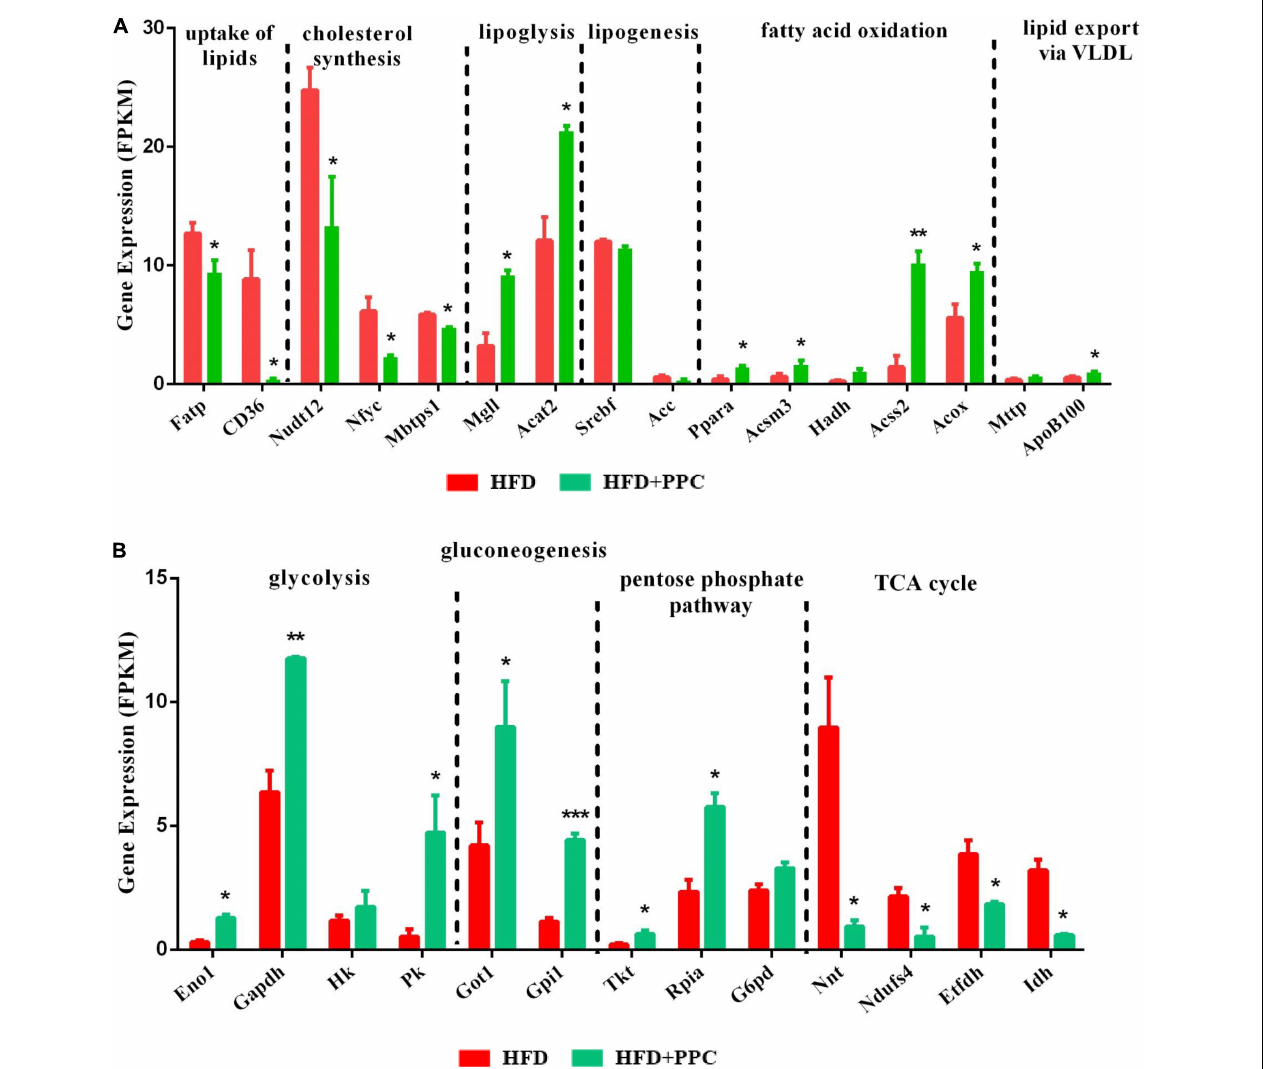
FIGURE 6 | PPC supplementation reprograms the glucose and lipid metabolism in the liver of mice fed by HFD. (A) The expression of genes in lipid metabolism. (B) The expression of genes in glucose metabolism. n = 3 for each group. The differences were analyzed using two-tailed Student’s t -test. Data represent means with SEM. Asterisks indicate statistically significant differences compared to the HFD group. * P < 0.05, ** P < 0.01, *** P <